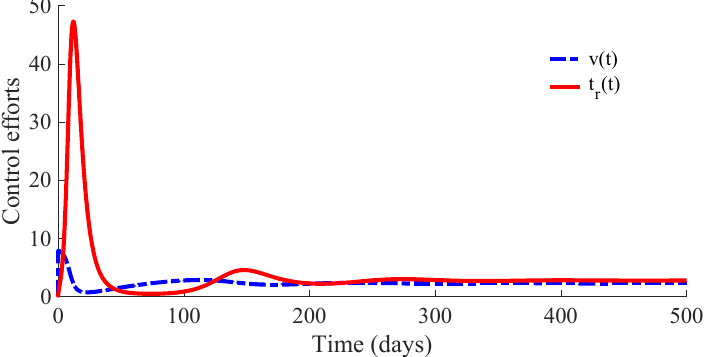
Figure 9. Time evolution of the control efforts under an insufficient vaccination and treatment.